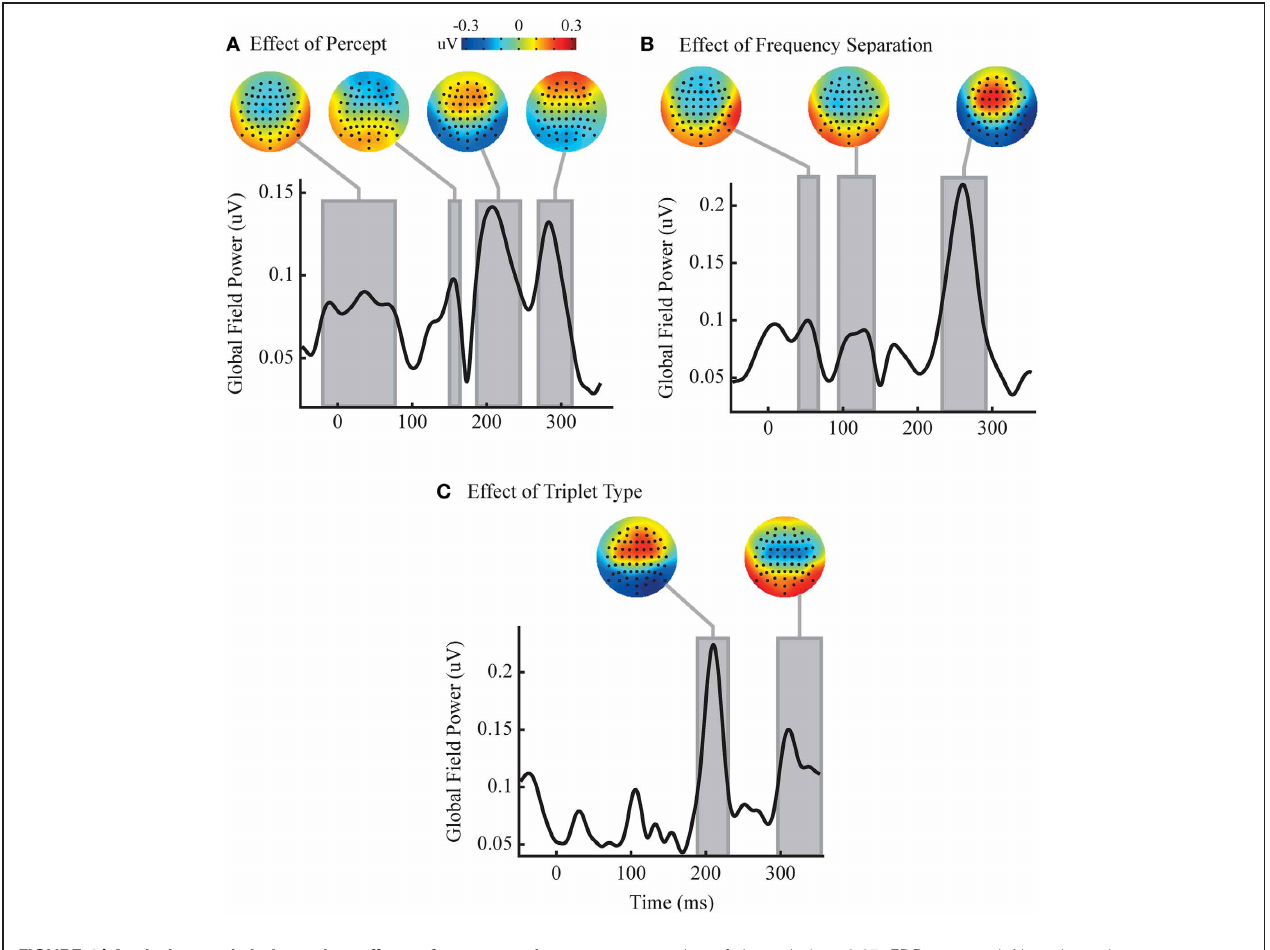
FIGURE 4 | Analysis reveals independent effects of percept and stimulus changes. Each of the three axes shows the temporal evolution of the GFP of the group perceptual ( split minus grouped , A ), frequency separation ( large minus small , B ) and triplet sequence ( HLH minus LHL , C ) difference waves. Gray boxes represent significant time windows where an ANOVA finds a significant main effect for the relevant factor in a large